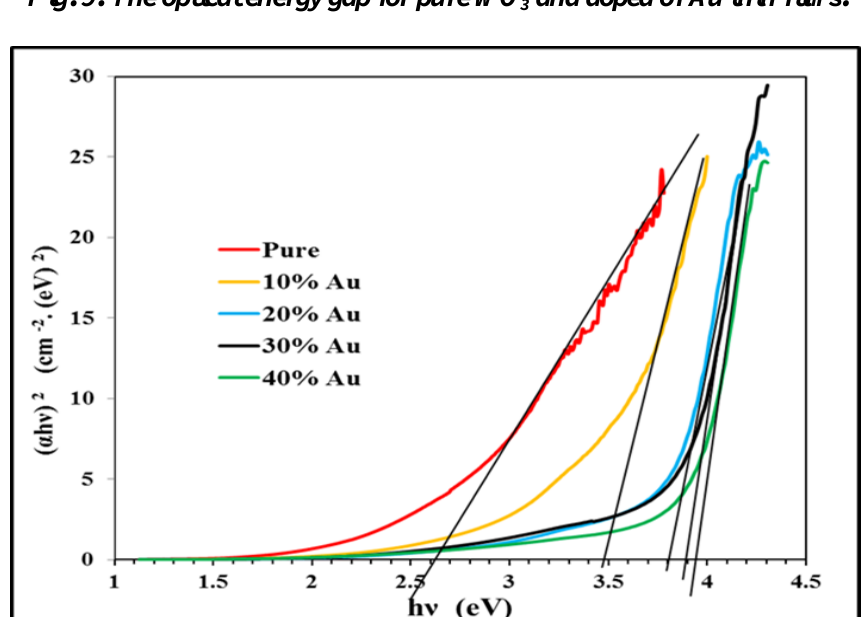
Fig. 10: The optical energy gap for pure WO